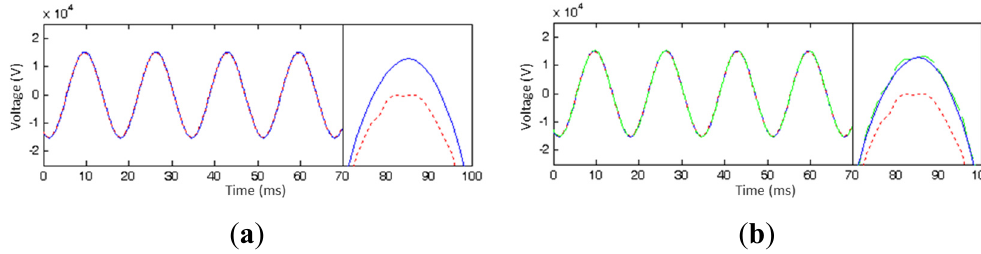
Figure 13. Results for 80% of the rated voltage: ( a ) v 1 (solid) and av 2 (dotted); and